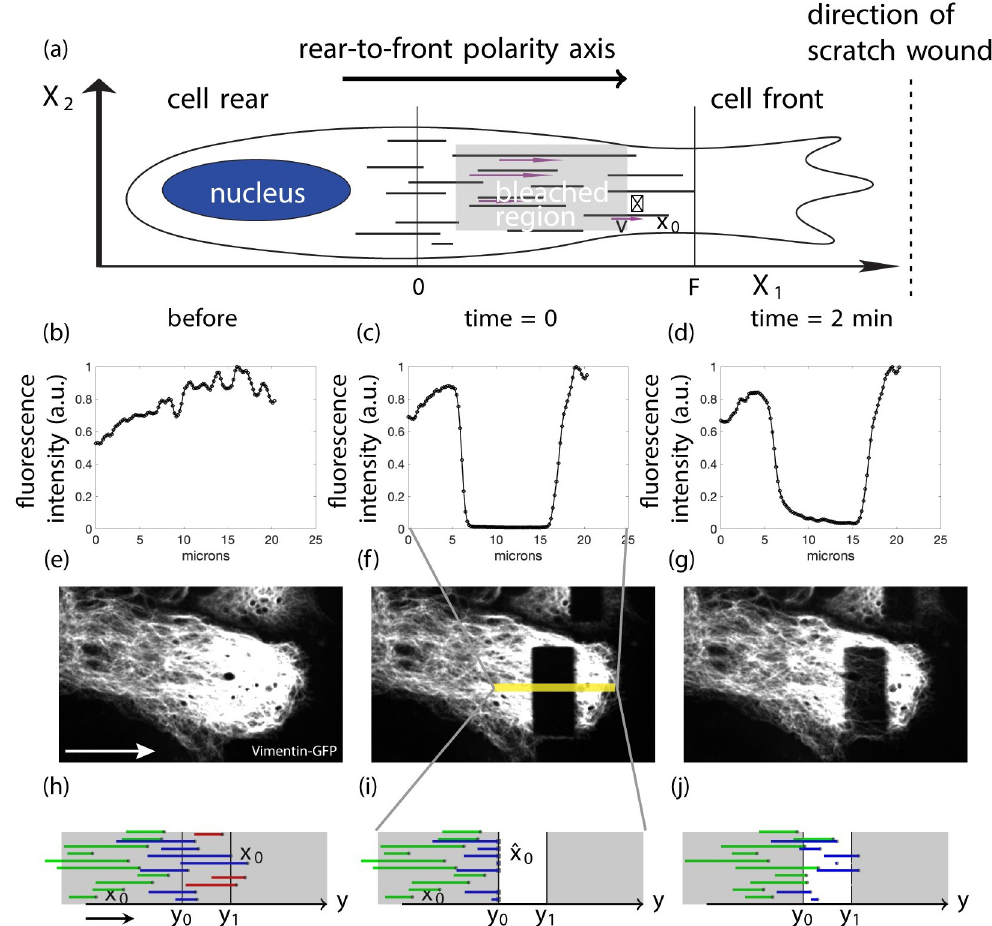
Fig 1. A schematic of the model and an example of a FRAP experiment. Panel (a) shows the schematic representation of a cell migrating to the right with several cytoplasmic IFs. Selected velocities are denoted with purple arrows under the filaments. The right endpoints of the IFs are denoted x 0 and one is labeled with its length ℓ and velocity v . The right endpoints are distributed between 0 and F . Panels (b)-(g) show data from a FRAP experiment. Panels (b)-(d) show the profile curves for (e)-(g) respectively. The curves in (b)-(d) come from data in a subregion of (e)-(g); for example the yellow box in (f). Panels (e)-(g) show fluorescence images taken from a FRAP experiment performed on vimentin-EGFP expressing astrocytes, located at the edge of a wound, 1h after wounding of the monolayer. The rear-to-front polarity axis similar to the direction of migration is indicated by an arrow in (a), (e) and (h). Data are before (b) and (e), just after (c) and (f), and 2 minutes after bleaching (d) and (g). Panels (h)-(j) are blowups of the region indicated by the yellow box in (f) and show the domain and setup for the simulations. For the clarity, the vertical coordinate of each filament stays the same. The photobleached region (shown in white in (i) and (j)) is between y 0 and y 1 . Several filaments are shown with their initial right endpoint depicted by a dot in (h)-(j). The red filaments are not relevant for our mathematical analysis and simulations since we consider only right moving filaments. Of the remaining filaments, the green ones are unbleached and the blue ones are partially bleached. In (i) the squares denoted ^ x show where the new right endpoints will be after bleaching. In the 0 mathematical analysis and simulations it is as if all the filaments to the right of y 0 are bleached since we only consider right moving filaments. filaments to move in the positive X direction (direction of the width of the bleached region) 1 independent of the other filaments. Formally the mathematical model of motion can be stated as: let x ( t ) be the position of the right endpoint of the fiber at time t , with v � 0 the velocity, x 0 the initial position, and ℓ the fiber length which does not change in time. Then ; x ð t Þ ¼ vt þ x 0